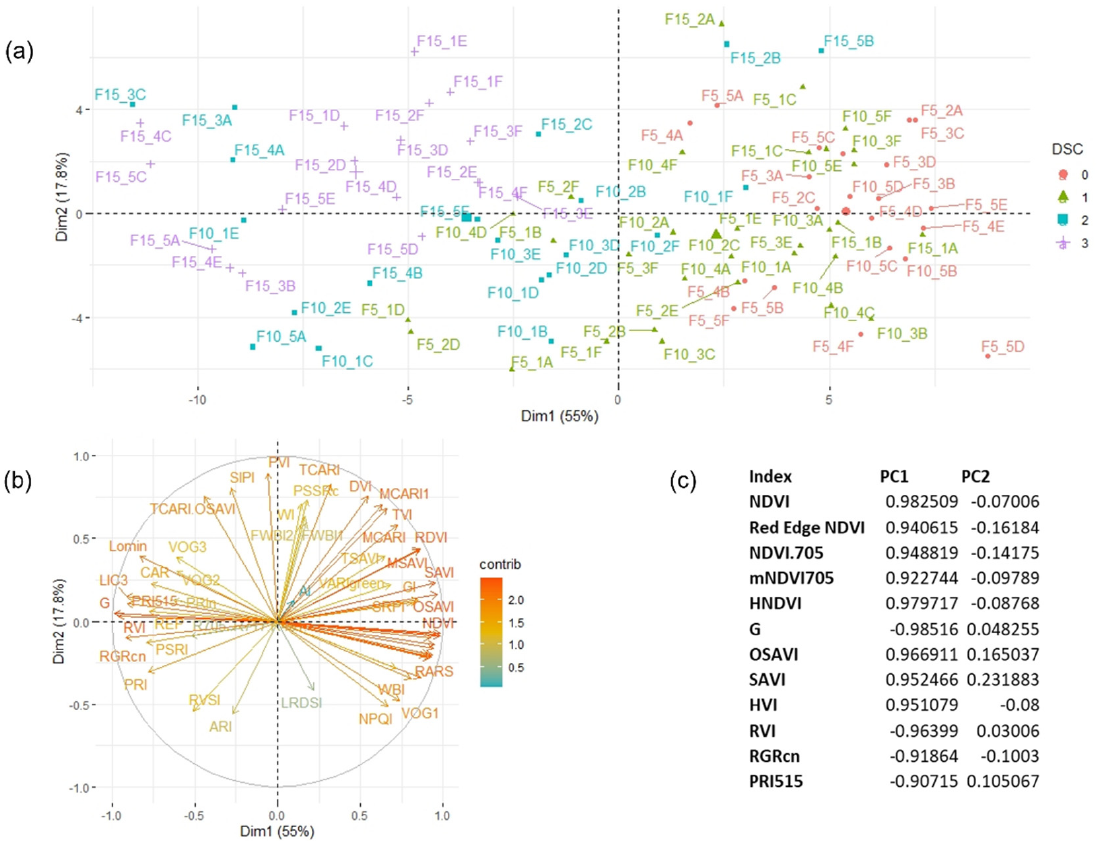
Figure 4. Principal component analysis biplot for Fusarium (F)-infected wild rocket plants (n = 90) examined at 5, 10, and 15 dpi in each replicate (1–5) per pot (A–F) (cases, panel ( a )) for differential values (infected − healthy) of 54 literature vegetation indices (variables, on panel ( b )) according to principal component 1 (PC1) and 2 (PC2) explaining 55.0 and 17.8% of the total variance, respectively. The colors in panel A are related to the observed disease severity classes while in panel b are linked to the contributions (contrib) of each VI to the definition of the principal dimensions. Coefficients of variable correlation with the two principal components are showed in panel ( c